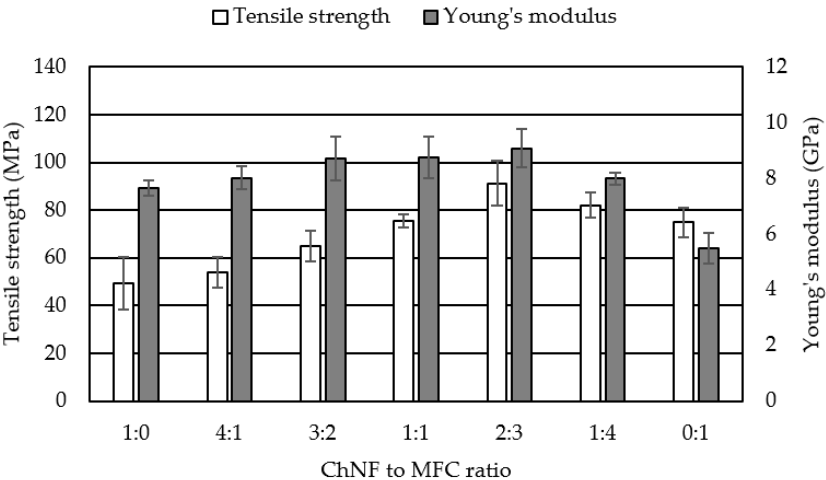
Figure 2. Tensile strength and Young’s modulus of nanocomposites with 75 wt % reinforcing phase with varying chitin nanofiber (ChNF) to microfibrillated cellulose (MFC) ratios.